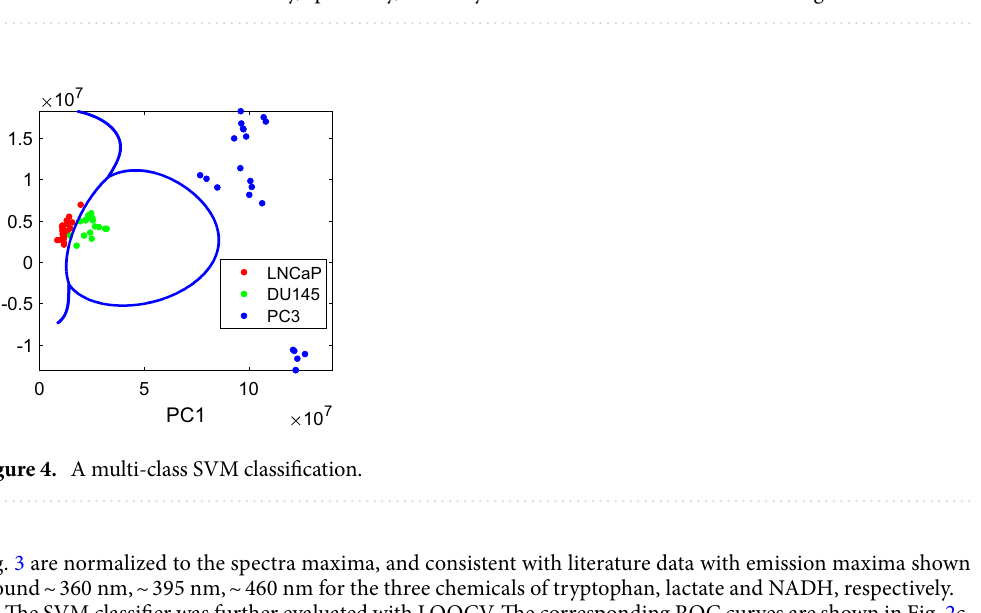
Table 1. Cross-validated sensitivity, specificity, accuracy and AUROC for LOOCV SVM using PCA.